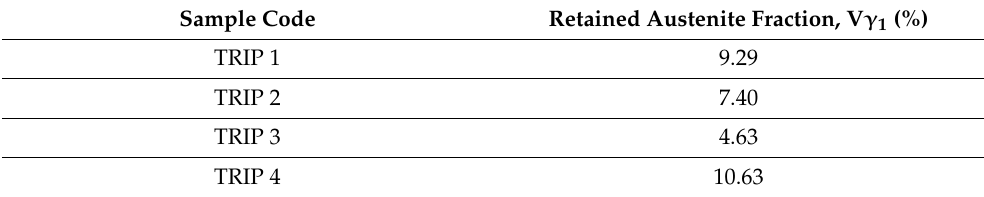
Table 4. Retained austenite fraction in heat-treated samples, V γ 1 .